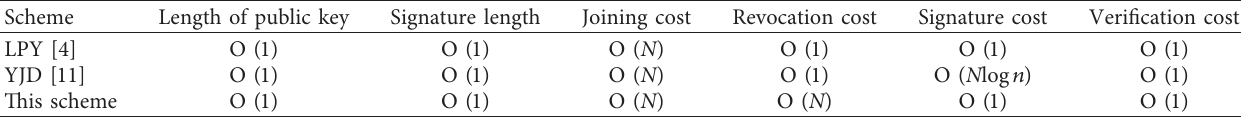
Table 1: Performance analysis.